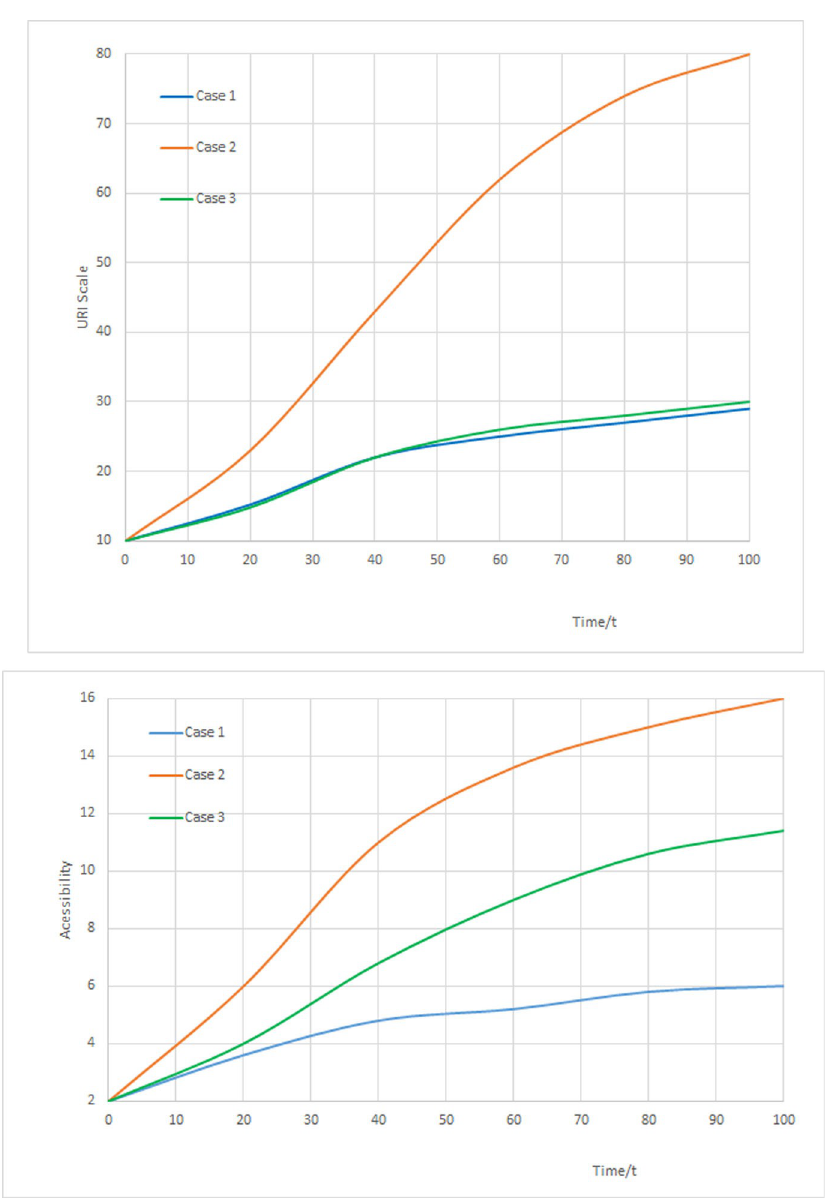
Fig 2. Simulation results at equilibrium